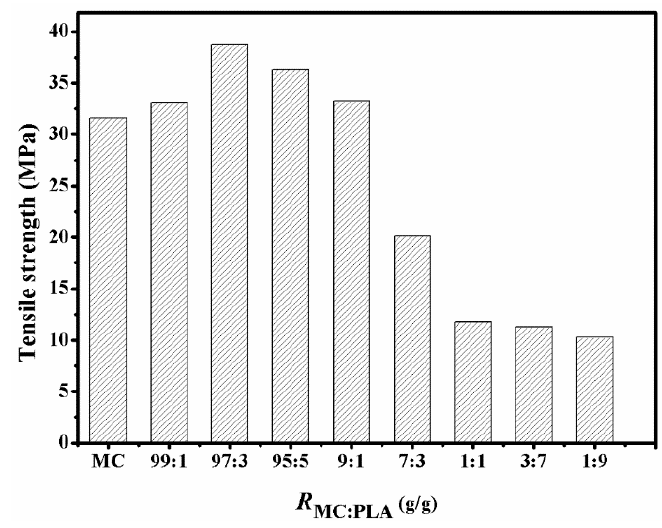
Figure 7. Tensile strength of MC and MC/PLA membranes as a function of MC/PLA mass ratio ( R MC:PLA ).